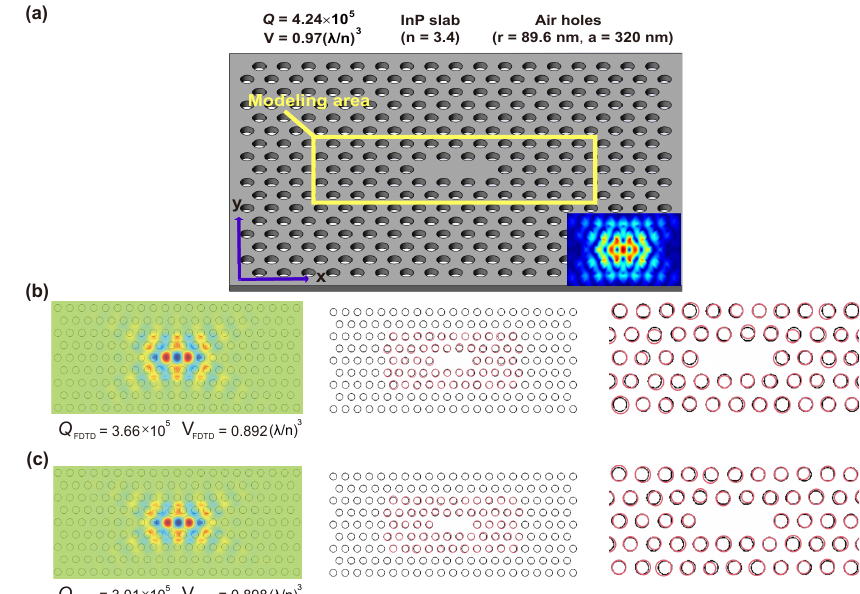
Figure 5. L3 nanocavity structure. ( a ) The initial structure’s design parameters and optical properties. Yellow box is the region where we randomly fluctuate the design parameters. Inset: the E y field of the initial structure. ( b , c ) Two samples in the dataset with randomly shifted holes. Black: original holes; red: shifted holes. Far right figures are magnified views of the